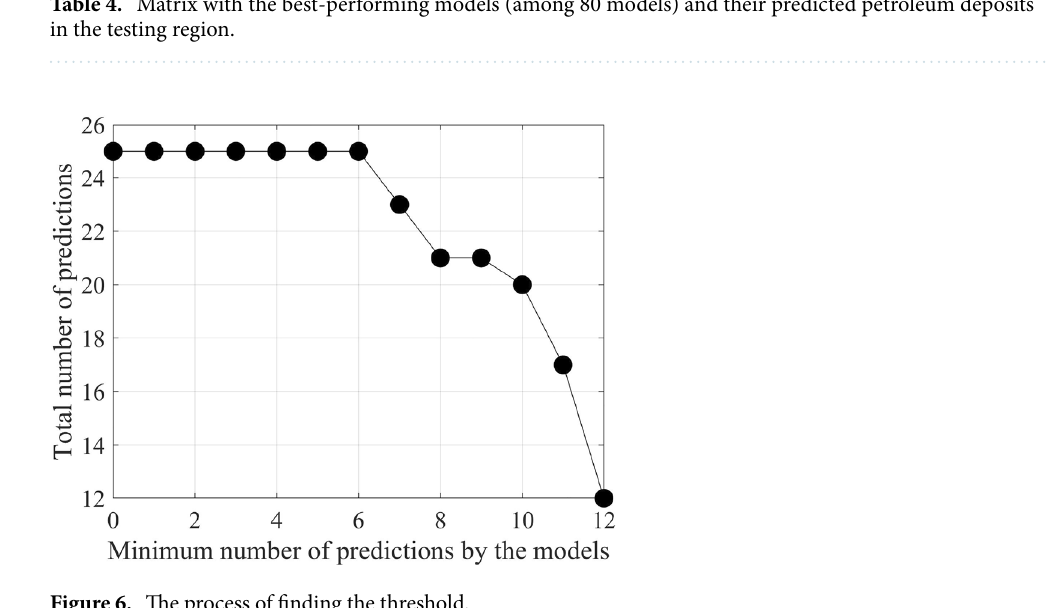
Figure 6. The process of finding the